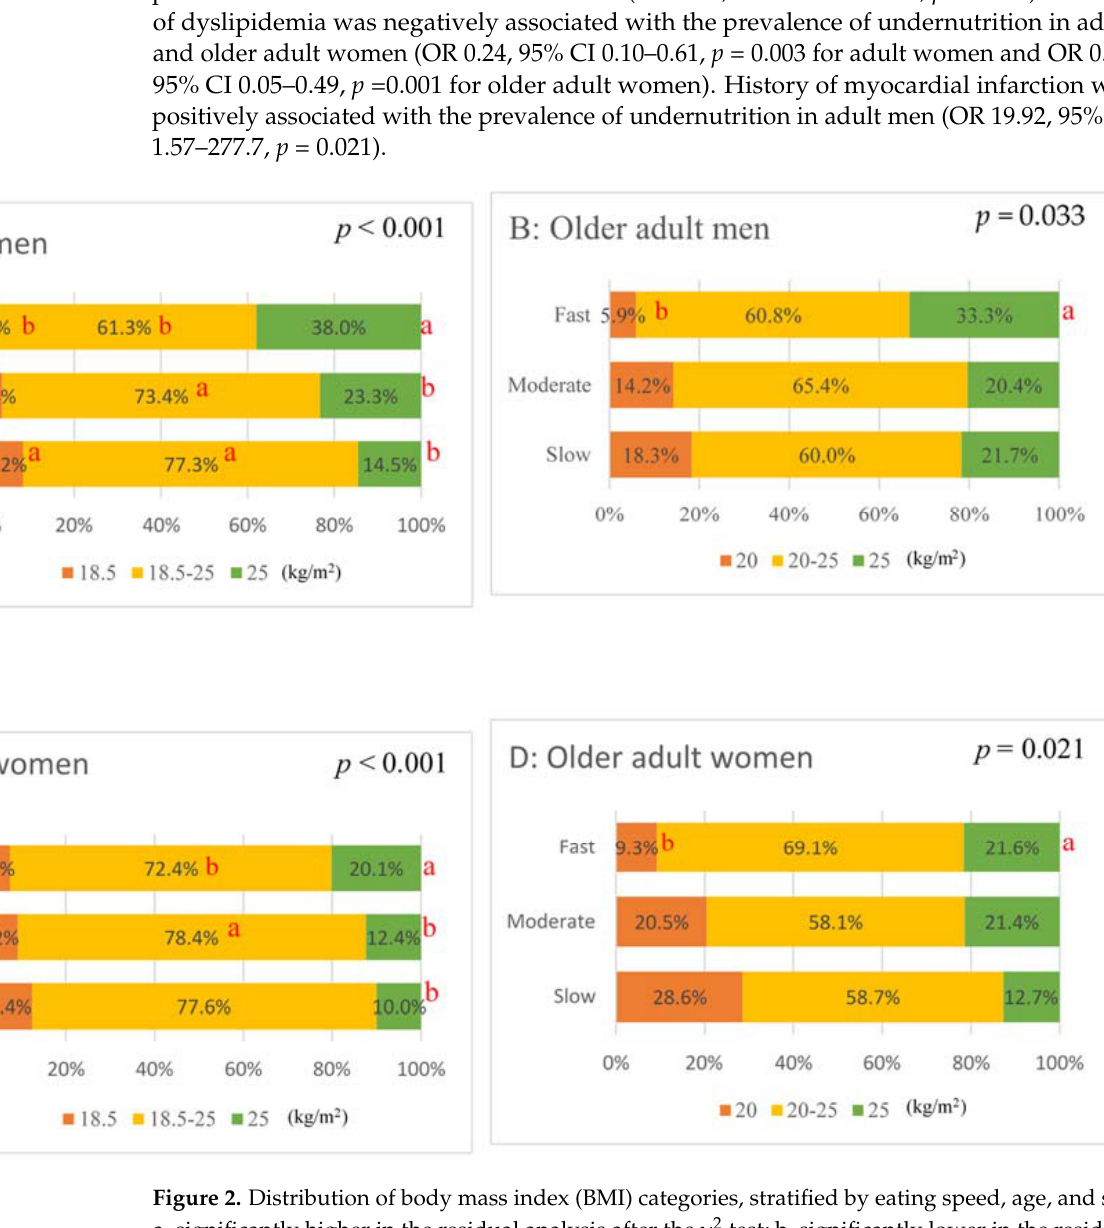
Figure 2. Distribution of body mass index (BMI) categories, stratified by eating speed, age, and sex. a, significantly higher in the residual analysis after the χ 2 test; b, significantly lower in the residual analysis after the χ 2 test. Distribution of BMI categories (%) stratified by eating speed; ( A ), for adult men; ( B ), for older adult men; ( C ), for adult women; ( D ), for older adult women.